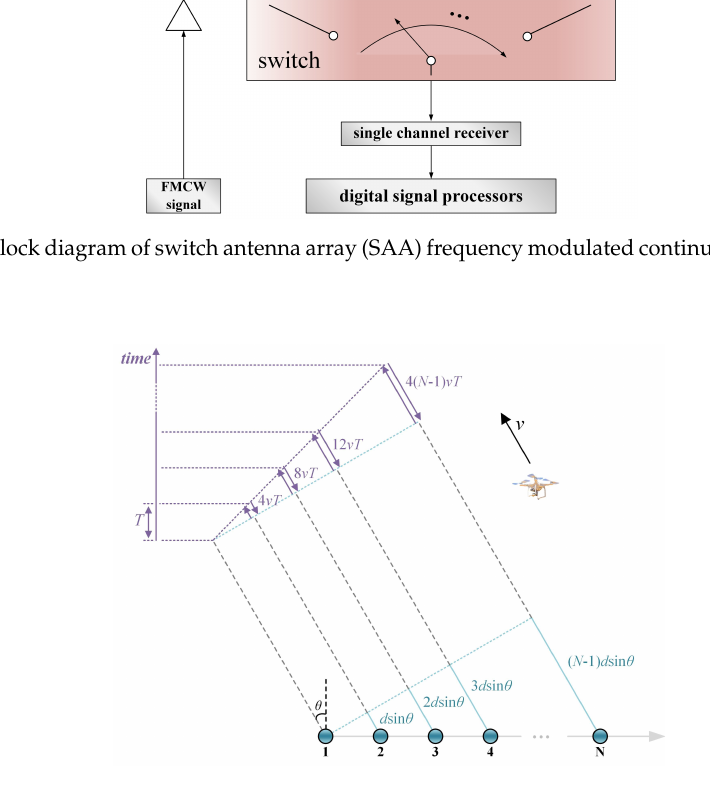
Figure 2. Phase distribution for moving